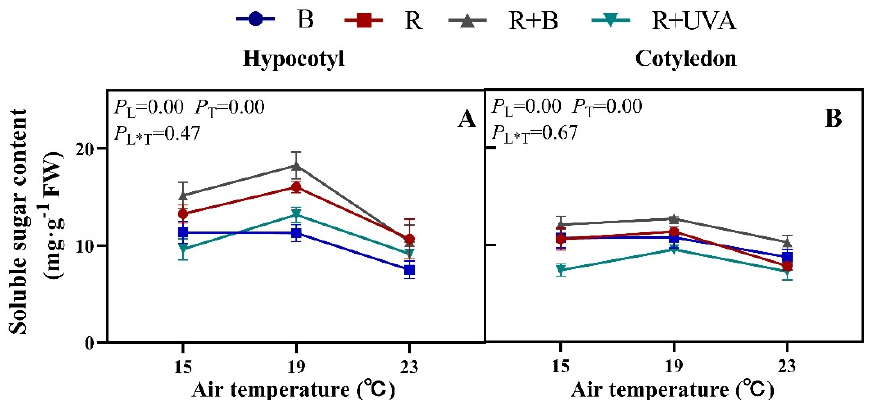
Figure 5. Soluble sugar content of broccoli sprouts grown for 5 d under different light [blue (B), red (R), mixture of R and B (R+B), as well as mixture of R and UVA (R+UVA)] and air temperature (15, 19, and 23 °C) regimes. Panel ( A ) refers to hypocotyl, and panel ( B ) to cotyledon. Error bars indicate SEM (n = 3, each replicate representing the mean of five petri dishes). FW, fresh weight.